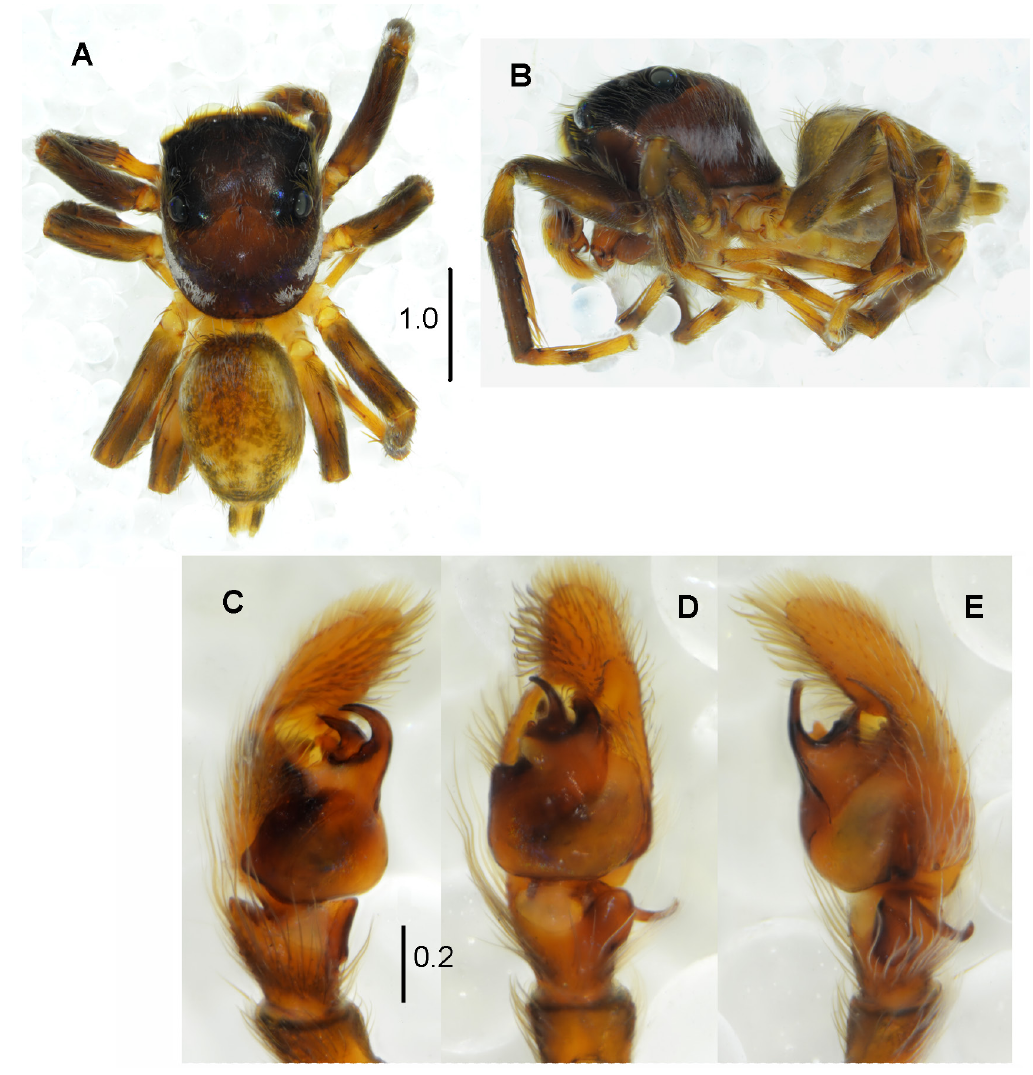
Fig. 53. Pochytoides tournieri sp. nov., holotype, ♂ (MNHN). A . Habitus, dorsal view. B . Habitus, lateral view. C . Palpal organ, ventroprolateral view. D . Palpal organ, ventral view. E . Palpal organ, lateral